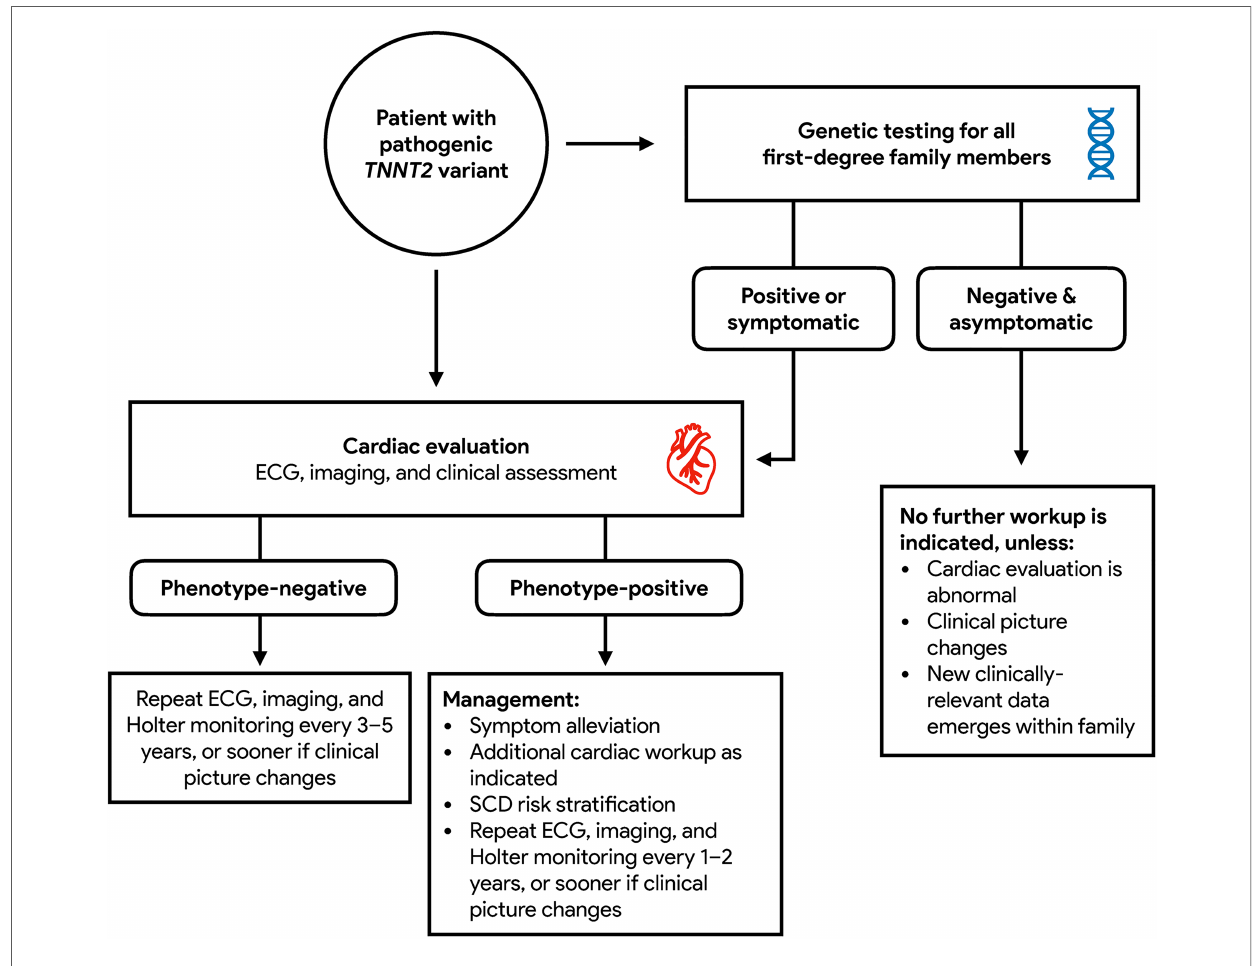
FIGURE 4 Recommended diagnostic paradigm for TNNT2